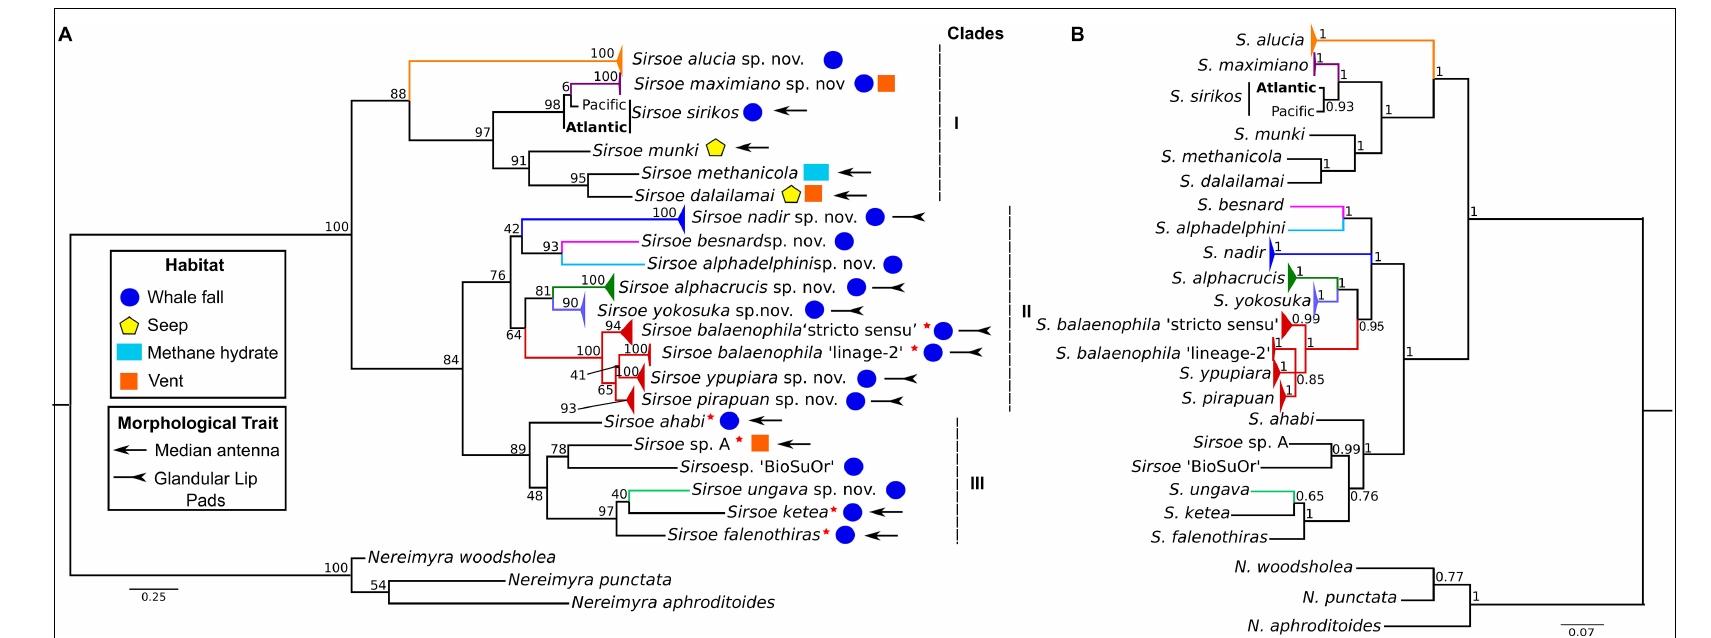
FIGURE 3 | Phylogenetic relationships of Sirsoe of the concatenated dataset (COI + 16S). (A) Phylogeny based on Maximum Likelihood (ML); (B) Phylogeny based on Bayesian inference (BI). Values close to nodes are bootstrap supports of ML and posterior probabilities supports of BI. Red star close to species name indicates former species within Vrijenhoekia genus. Habitat use: circle – whale fall; pentagon – seep; rectangle – methane hydrate; square – vent. Morphological trait: arrow – median antenna present; inverted arrow – glandular lip pads present; species without symbol for morphological trait indicate absence of median antenna and glandular lip